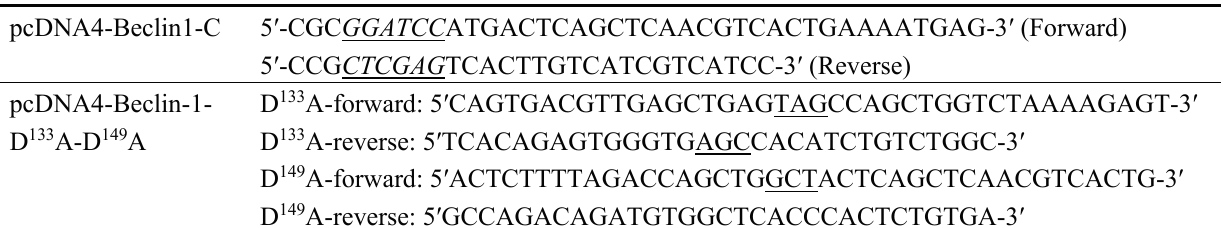
Table 1. List of primers used for cloning Beclin-1C and generating caspase-resistant Beclin-1